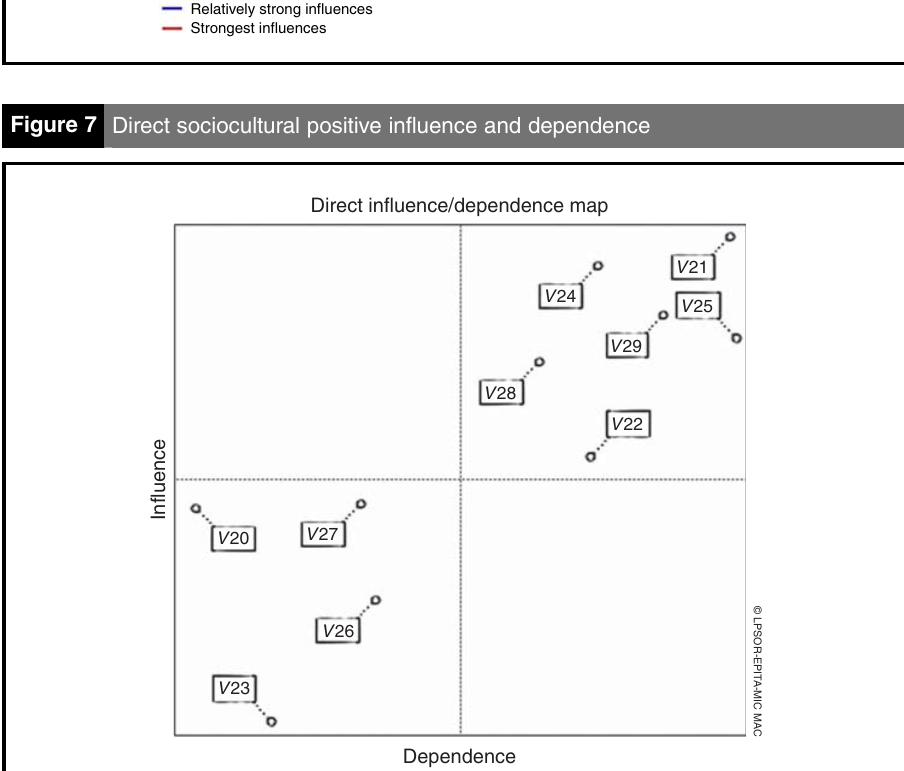
Figure 7 Direct sociocultural positive influence and